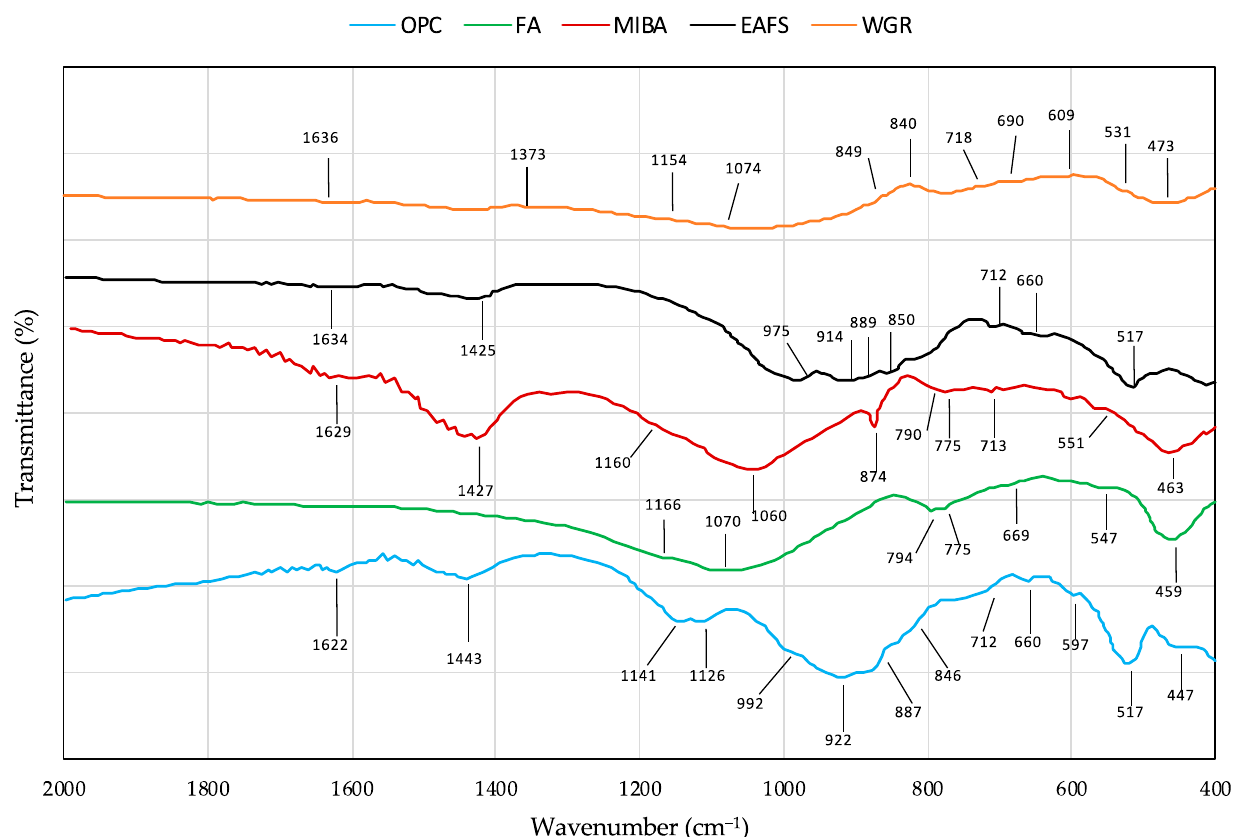
Figure 6. FTIR spectra of OPC, FA, MIBA, EAFS, and